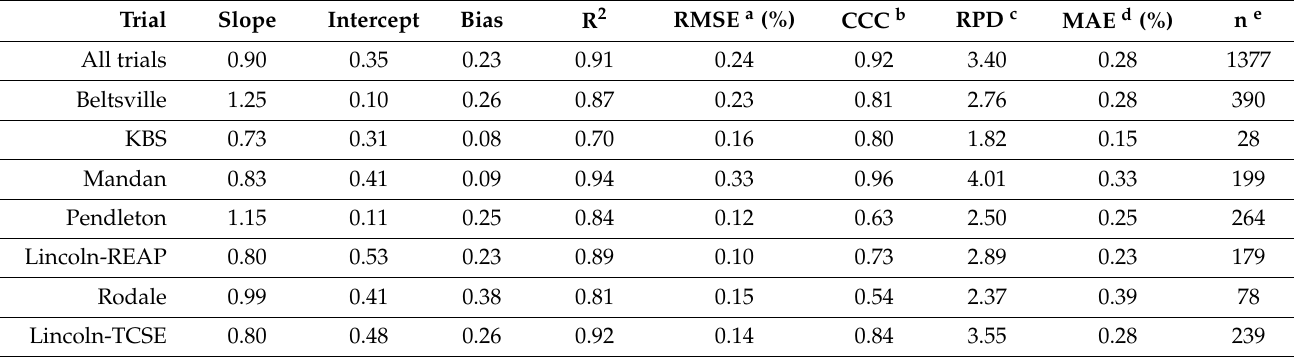
Slope, intercept and bias of linear regression, RMSE a = root mean square error, CCC b = concordance correlation coefficient, RPD c = residual prediction deviation, MA d = mean absolute error, n e = sample size.